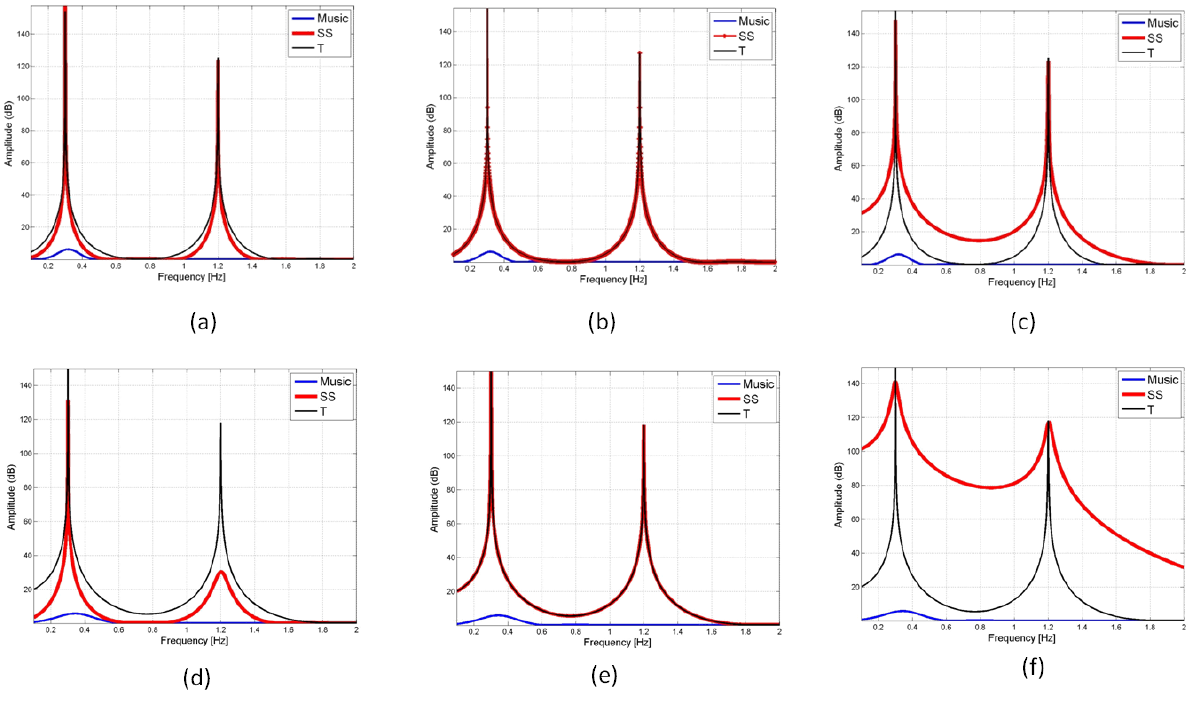
Figure 4: Synthetic data by varying the acquisition time and the decorrelation index. Pseudospectrum comparison between SS (red line) and Toeplitz (black line): (a) ∆ tL = 5 s , M d = 51 , (b) ∆ tL = 5 s , M d = L/ 2 = 100 , (c) ∆ tL = 5 s , M d = 151 , (d) ∆ tL = 3 s , M d = 11 , (e) ∆ tL = 3 s , M d = L/ 2 = 60 , (f) ∆ tL = 3 s , M d =